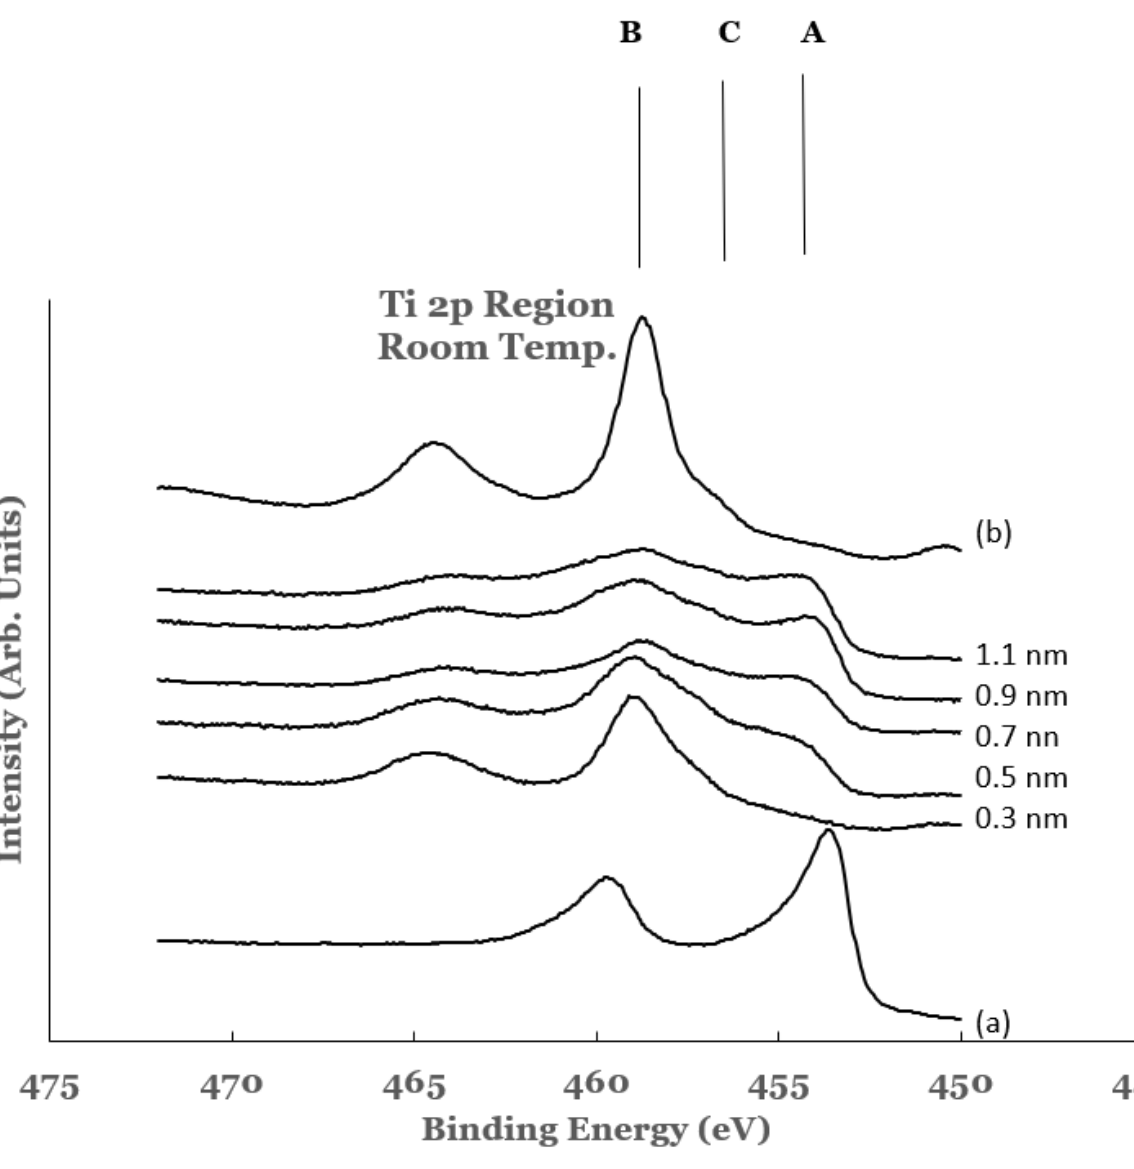
Figure 4. Spectral data in the Ti 2p region as a function of the titanium overlayer. The overlayer was deposited at room temperature. Vertical lines represent the positions of the 2p 3/2 core level of titanium in the different chemical states of titanium. Line A represents the position of the 2p 3/2 core level for elemental Ti, line B that for TiO 2 , and line C that for Ti-suboxide. Spectrum (a) corresponds to that for elemental Ti while spectrum (b) to that for TiO 2 .